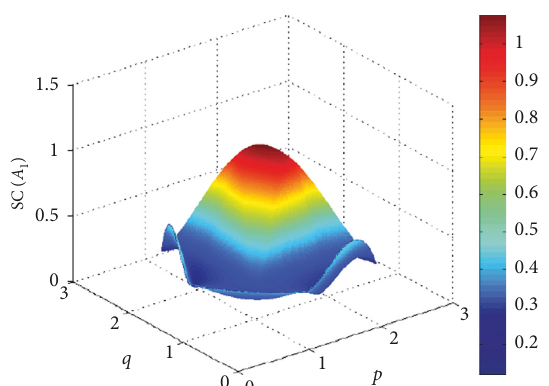
Figure 11: SC ( F and the A-HF2TLWGBM operator.